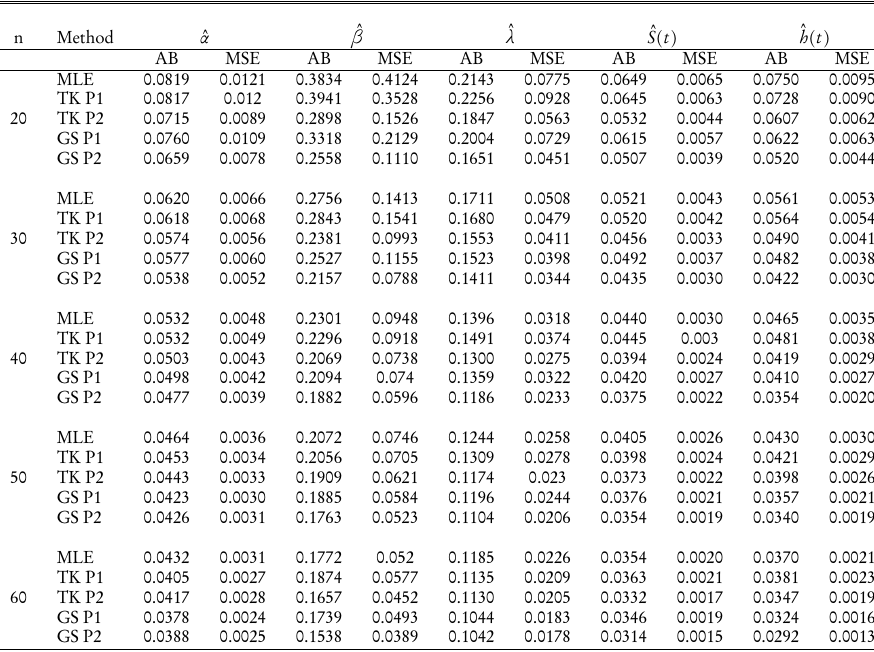
ML and Bayes estimates of parameters and reliability characteristics when α = 0.5, β = 1.5, λ = 1,